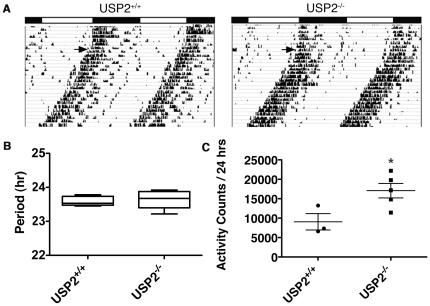
Loss of USP2 does not alter circadian period.
A. Representative double plotted wheel running records for age matched USP2+/+ and USP2−/− mice over 33 days (Y-axis). Mice were initially on a 12-hour LD cycle, followed by a free-run period in DD from day 15 onward (arrow). Data were collected using ClockLab™ software. B. The median period measured in USP2+/+ mice (n = 5) is 23.53 hours and the 23.68 hours in USP2−/− mice (n = 6). The box represents the percentiles from 25th to 75th and the vertical whiskers represent the maximum and minimum periods measured for each genotype. C. Activity counts per 24 hours measured by running wheel revolutions are plotted for USP2+/+ (n = 3) and USP2−/− (n = 5) mice housed in constant darkness. The bars are the mean ± SEM and individual data points are plotted for each set; the median activity in USP2+/+ mice was 7341 revolutions/24 hours compared to 17,147 in USP2−/− mice. The asterisk signifies a significant difference using the un-paired t-test (p<0.05).